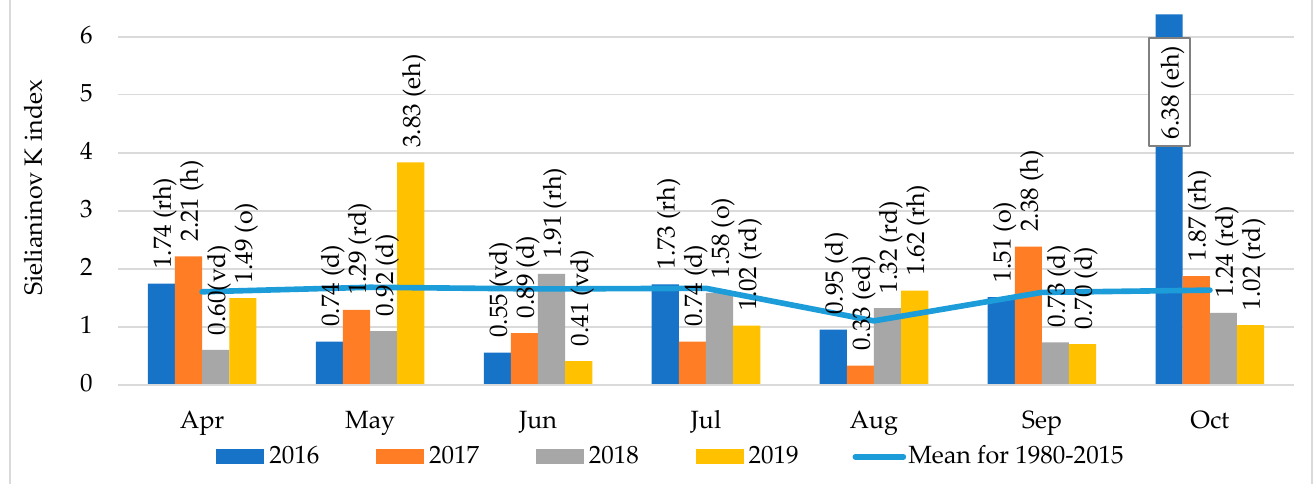
Figure 1. Sielianinov’s hydro-thermic coefficients K described for Poland by Skowera et al. [39]: K ≤ 0.4 extremely dry (ed), 0.4 < K ≤ 0.7 very dry (vd), 0.7 < K ≤ 1.0 dry (d), 1.0 < K ≤ 1.3 relatively dry (rd), 1.3 < K ≤ 1.6 optimal (o), 1.6 < K ≤ 2.0 relatively humid (rh), 2.0 < K ≤ 2.5 humid (h), 2.5 < K ≤ 3.0 very humid (vh), K > 3.0 extremely humid (eh).